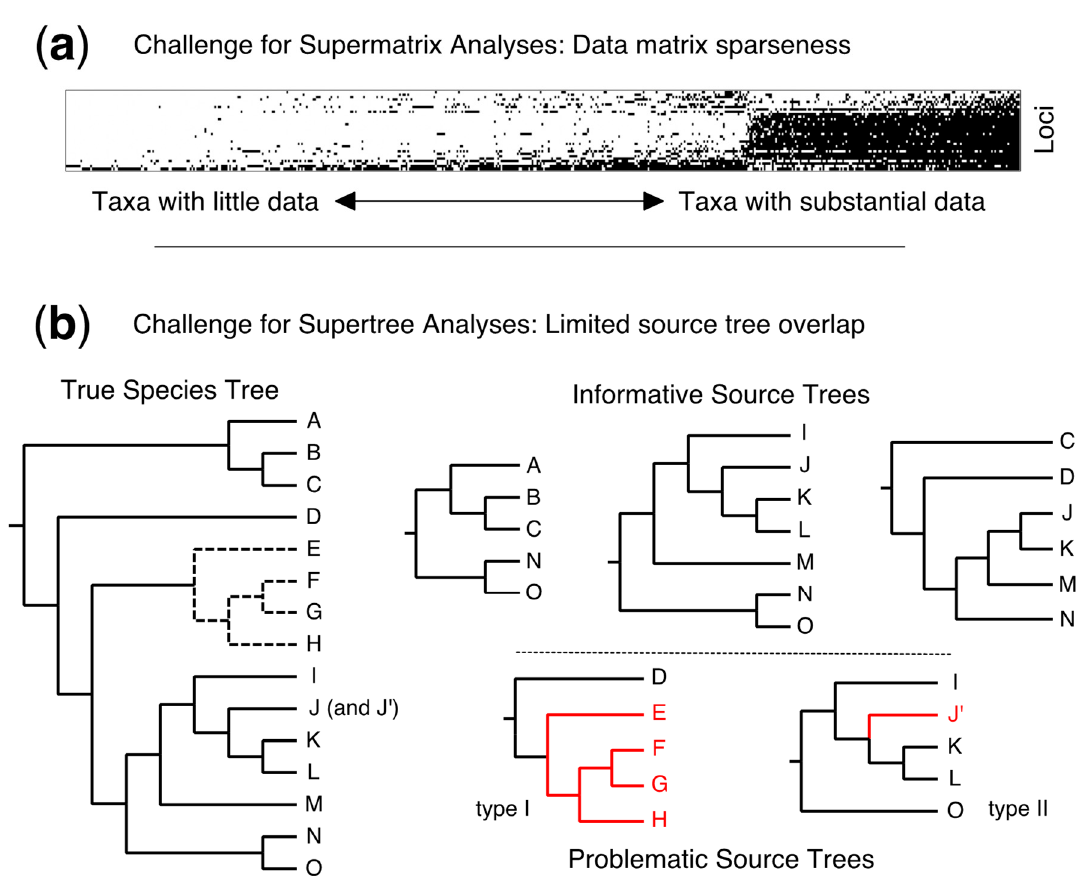
Figure 1. Challenges for megaphylogeny construction. ( a ) Supermatrix analyses often use sparse data matrices. The box shows part of the BigBird data matrix (Burleigh et al. 2015) with taxa plotted on the x-axis and loci on the y-axis. Sampled loci are black and missing data are white. The imperfect overlap of loci means some taxa will be placed using only one or two loci. Moreover, some sister taxa may not share any loci. ( b ) Supertree analyses do not require overlapping loci but specific patterns of taxon overlap in source trees are necessary. The source trees shown are sufficient to yield the parts of the true species tree with solid lines (assuming the source trees are accurate). Problematic source trees are of three types: (1) type I trees have only one taxon present in the other source trees, making it impossible to place the non-overlapping taxa; (2) type II trees include a taxon (J’) absent from other source trees that is a close relative of a taxon (J) in other informative source trees, in this case J and J’ may not emerge as sister taxa; and (3) type III (not shown) are cases in which a potential source tree does not share any taxa with any other source tree. Including additional source trees with appropriate taxa (if they are available) will render types I and III trees informative. Type II trees often reflect taxonomic changes that split species or cases where different studies use closely related but distinct taxa (e.g., congeners). Enforcing constraints that include a J + J’ clade can solve the problems caused by type II trees.